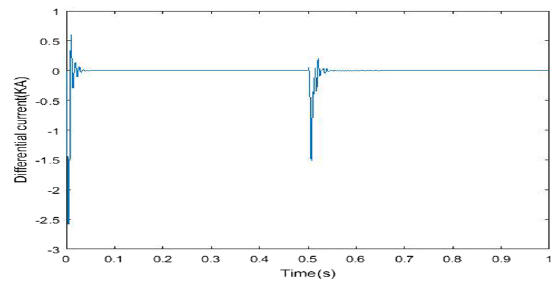
Fig. 8 Negative to ground fault on HVDC line at 25